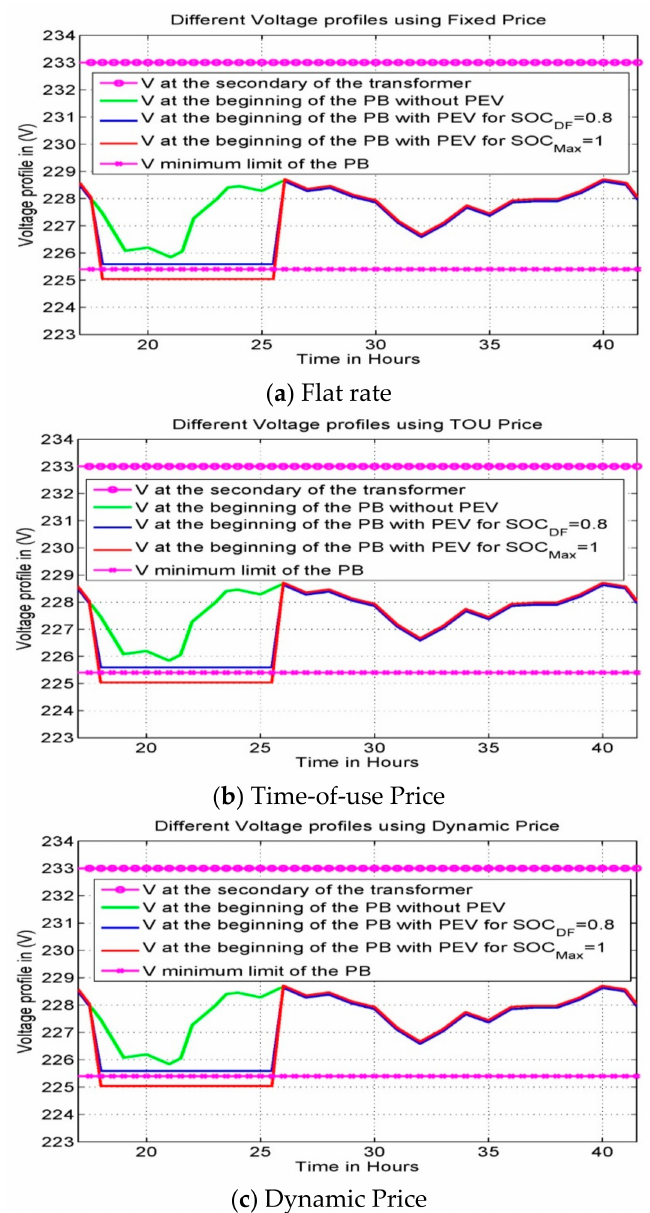
Figure 8. Voltage profiles for the baseload and total load for SOC Max = 1 and SOC D = 0.8, for ( a ) Flate rate, ( b ) TOU, ( c ) Dynamic